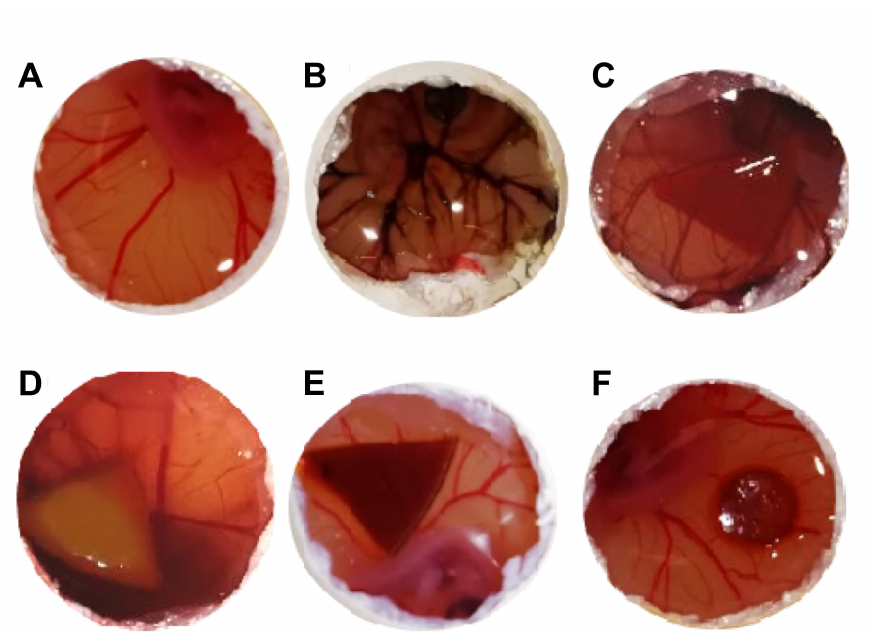
Figure 11. Chorioallantoic membrane images after 5 min of exposure to the negative control (NaCl 0.9%) ( A ), positive control (NaOH, 1 M) ( B ), and to the non-sterile ( C ), MW-3 ( D ), HHP ( E ), and PM ( F ) hydrogel